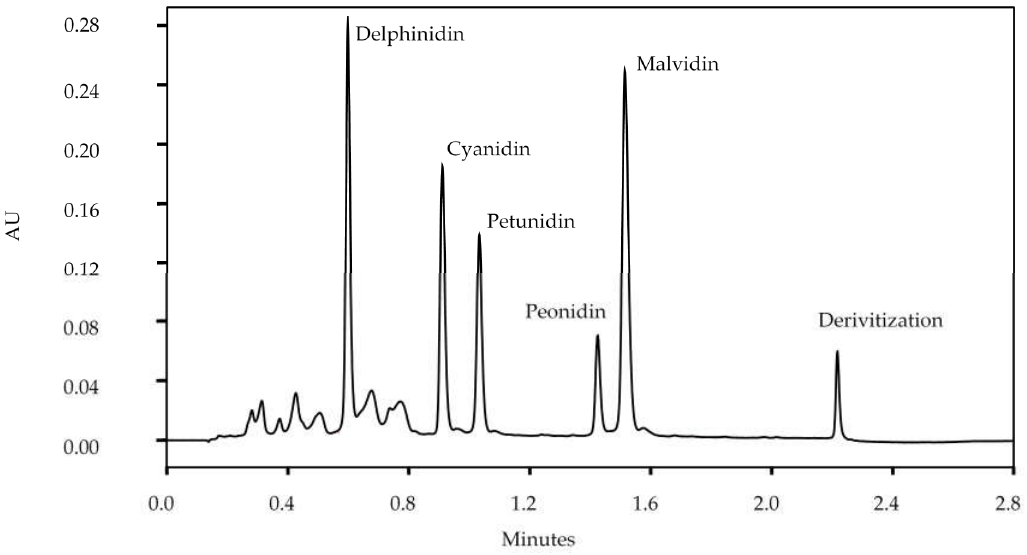
Figure 4. Anthocyanidins found in rabbiteye blueberry press cake (PRC) as detected by HPLC–UV.